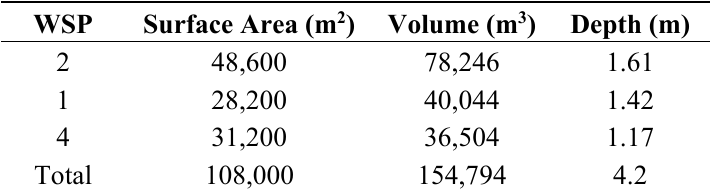
Table 1. Area, volume, and depth of the Amherstview Water Pollution Control Plant (WPCP) wastewater stabilization ponds (WSPs) based on field measurements performed in the summer of